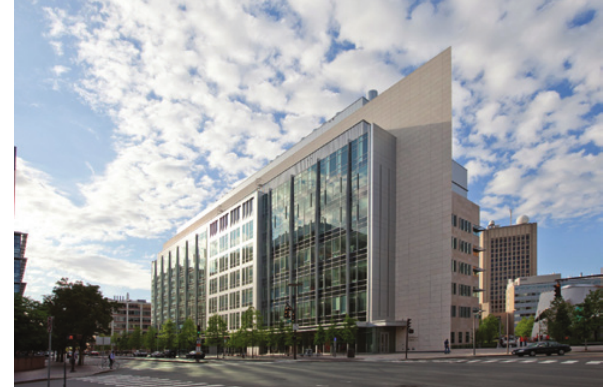
Figure 1: Colocalization. The Koch Institute for Integrative Cancer Research puts biologists, engineers, chemists, computer scientists, and clinicians under one roof. Picture provided courtesy of the Koch Institute.